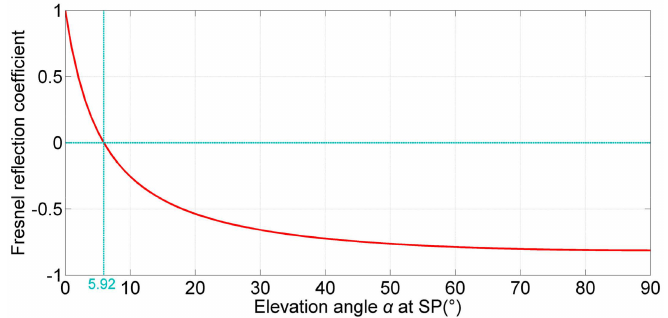
Figure 2. Relationship between elevation angle and Fresnel reflection coe ffi cient (right hand circularly polarized (RHCP) turns to left hand circularly polarized